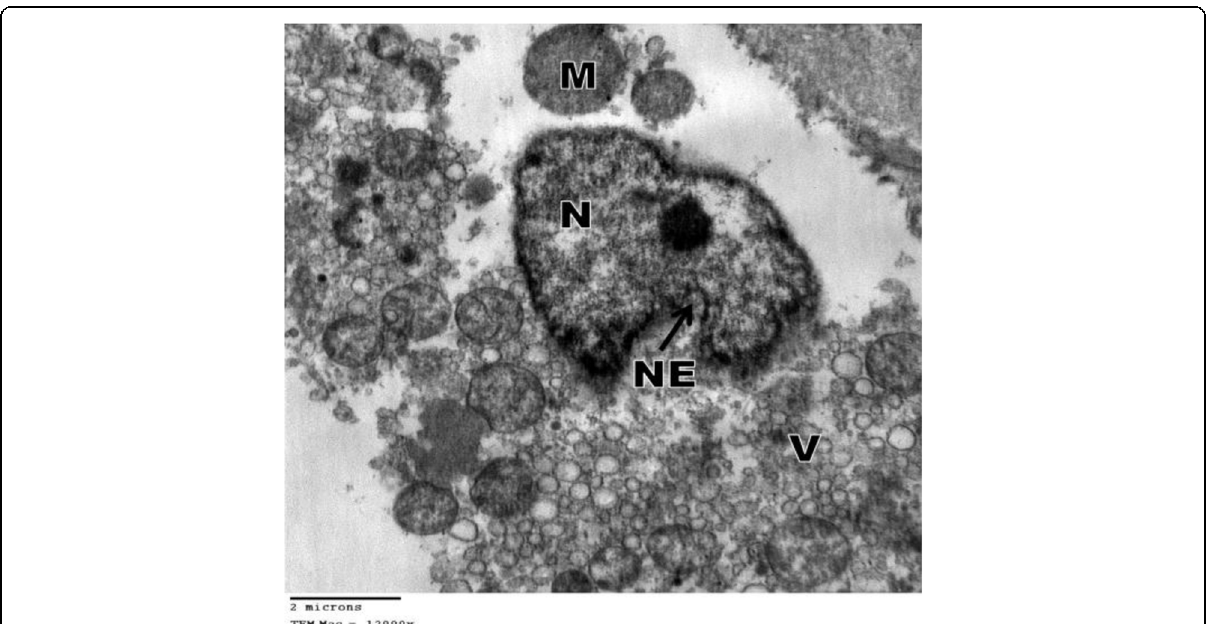
Fig. 26 An electron micrograph of a hepatocyte of treated mouse with Tamiflu (16 mg/kg b.wt.) in addition to Adamine (20 mg/kg b.wt.) for 5 days revealing desintigration of cytoplasm, swollen mitochondria (M), vacuoles (V), and the nucleus (N) with irregular nuclear envelope (NE). (×